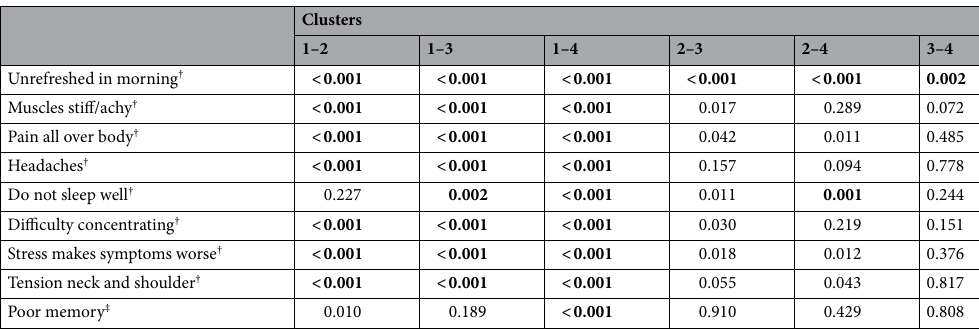
Table 3. Multiple comparisons of CSI9 items between clusters. The table shows p-values by Mann–Whitney U test. By multiple comparisons, the test is repeated six times in four clusters, with a significance level of p < 0.008